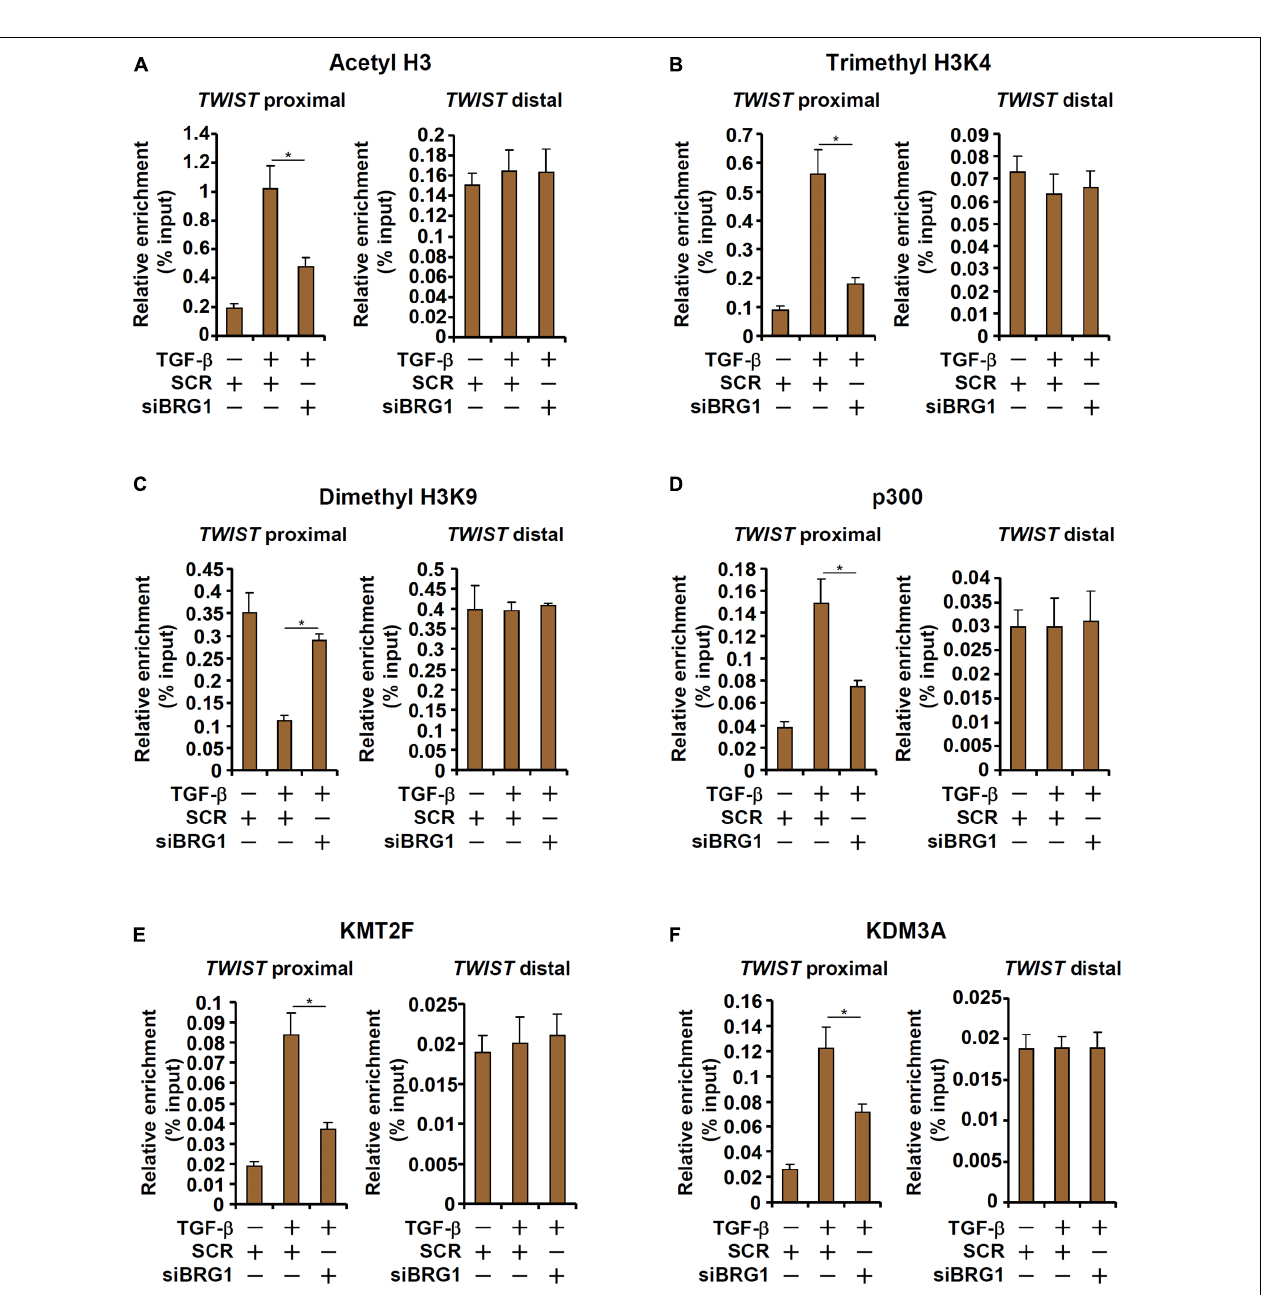
FIGURE 4 | BRG1 regulates TWIST transcription by modulating histone modifications. (A–F) HUVECs were transfected with siRNA targeting BRG1 or SCR followed by treatment with TGF- β . ChIP assays were performed with anti-acetyl H3 (A) , anti-trimethyl H3K4 (B) , anti-dimethyl H3K9 (C) , anti-p300 (D) , anti-KMT2F (E) , and anti-KDM3A (F) . Error bars represent SEM (* p < 0.05, two-way ANOVA with post-hoc Scheffe test). All experiments were repeated three times and data represent averages of three independent experiments.